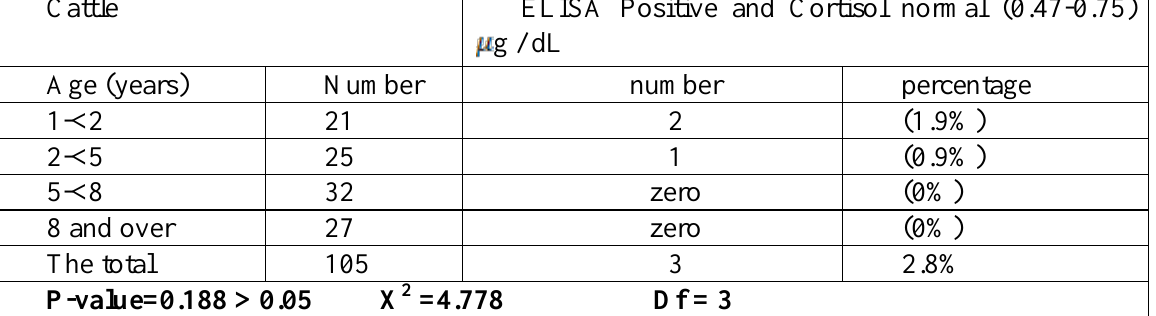
Table(5): The third group ELISA Positive and Cortisol at Normal level Cattle ELISA Positive and Cortisol normal (0.47-0.75)